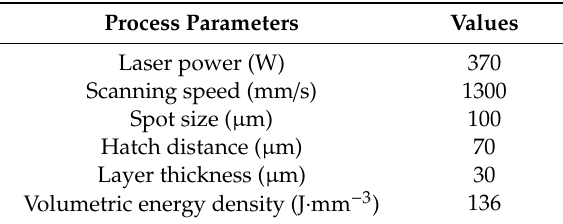
Table 1. The process parameters used for manufacturing AlSi10Mg alloy